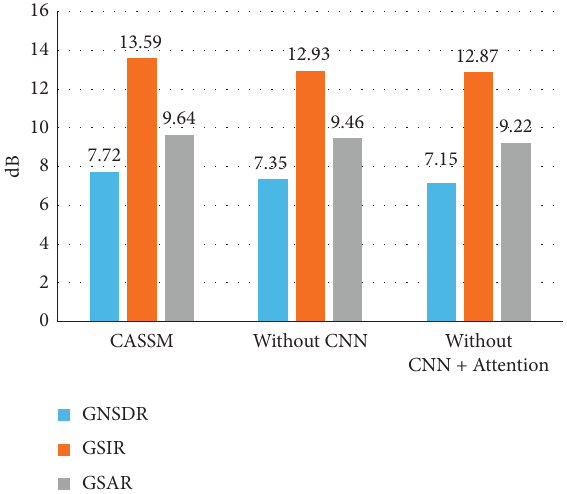
Figure 6: The comparison for the effect of ablation experiments.